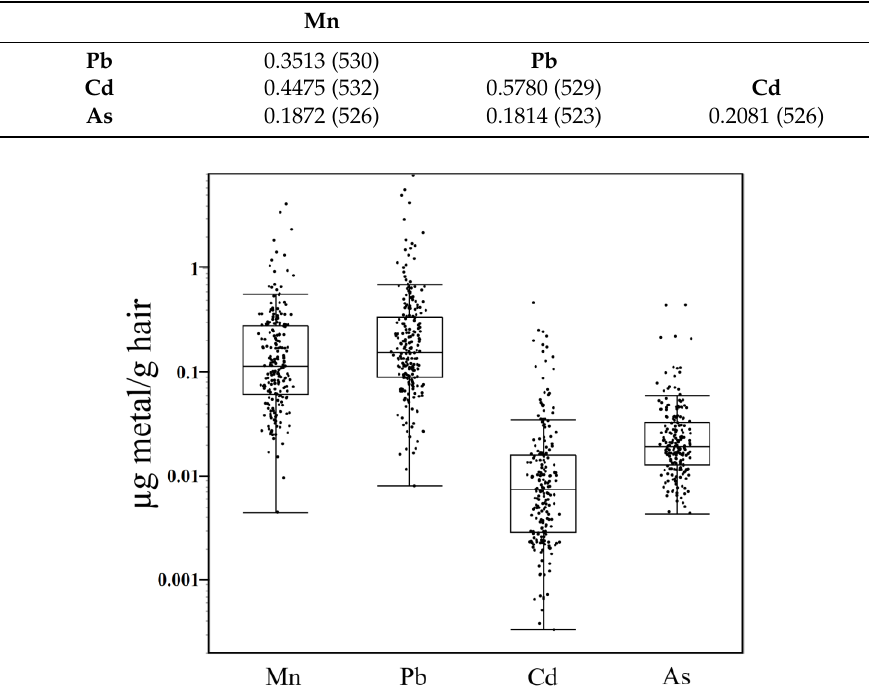
Table 2. Spearman’s correlation ( n = number of hair samples) between hair metal levels in all hair samples from males (proximal segment) and females (proximal, medial, and distal segments); all Spearman’s ρ values are highly significant, p < 0.0001).